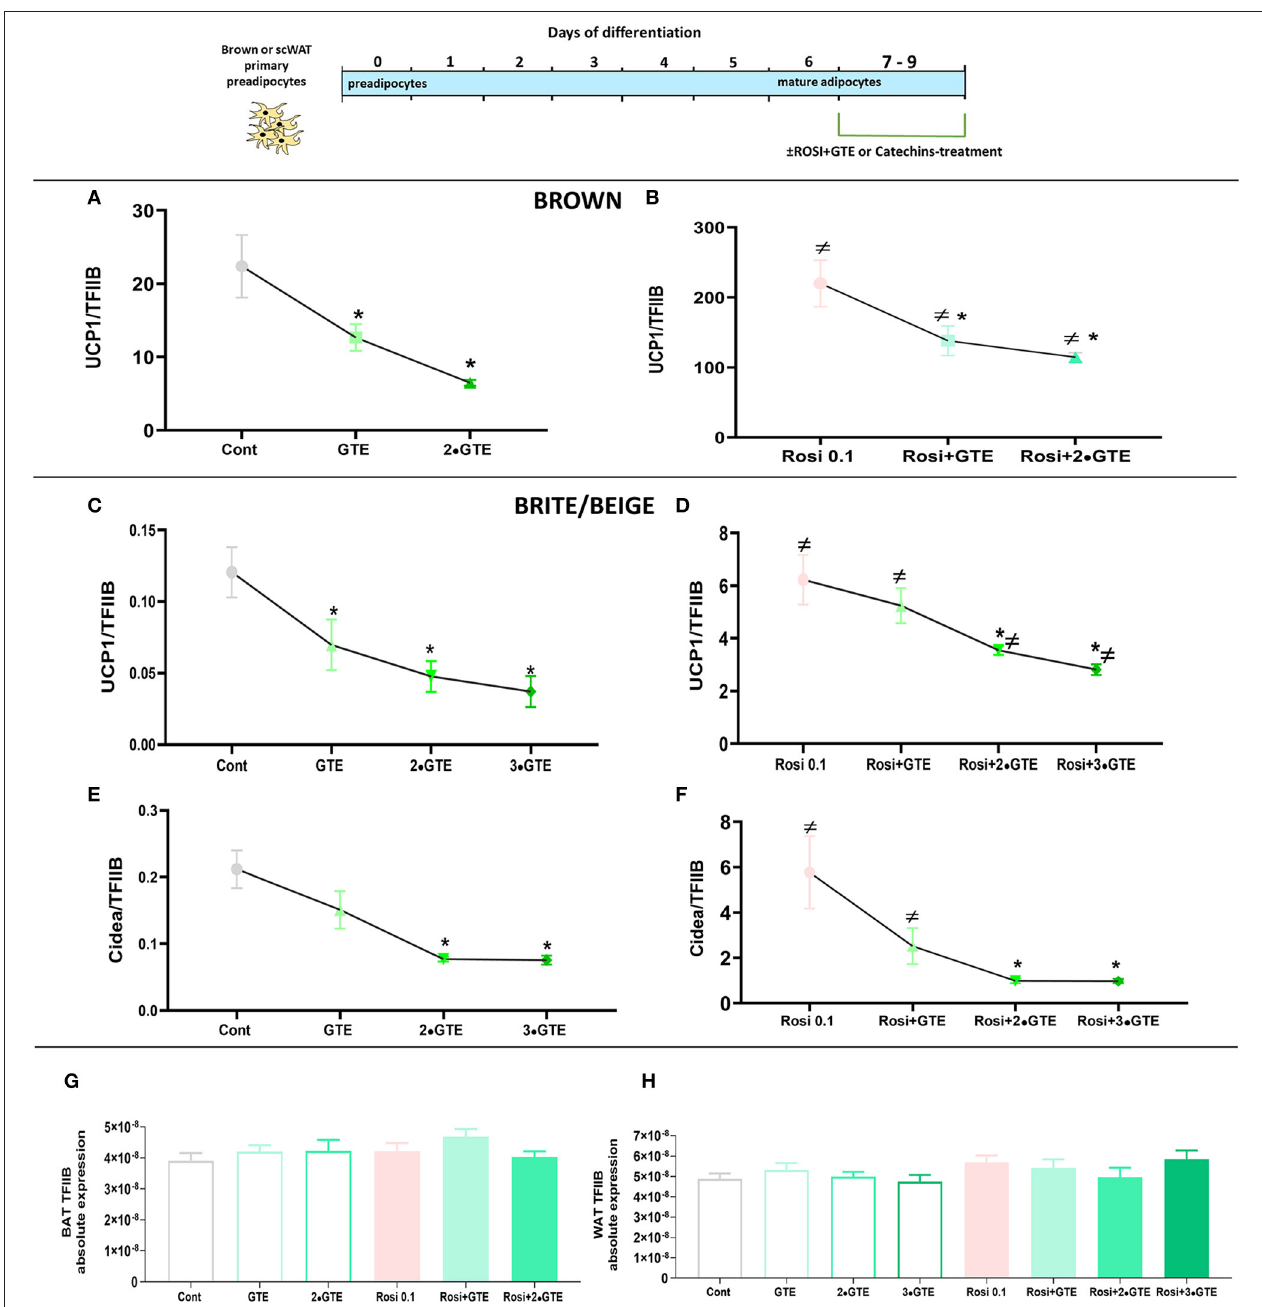
FIGURE 7 | Interaction between green tea extract and rosiglitazone. Mature brown and white adipocytes were differentiated until day 7 and treated thereafter, from day 7 to day 9, with the indicated doses of green tea extract (GTE), in the presence or absence of rosiglitazone. Ucp1 mRNA levels in brown adipocytes in basal (A) and rosiglitazone-stimulated (B) cells. (C,D) results for UCP1 mRNA levels in white adipocytes. (E,F) results for Cidea mRNA levels in white adipocytes. Ucp1 and Cidea mRNA levels were normalized to the TFIIB levels in each sample ( G TFIIB levels in brown adipocytes and H in white adipocytes). The results are means ± SEM of four independent experiments, each performed in duplicate. Statistics are as in Figure 1 .